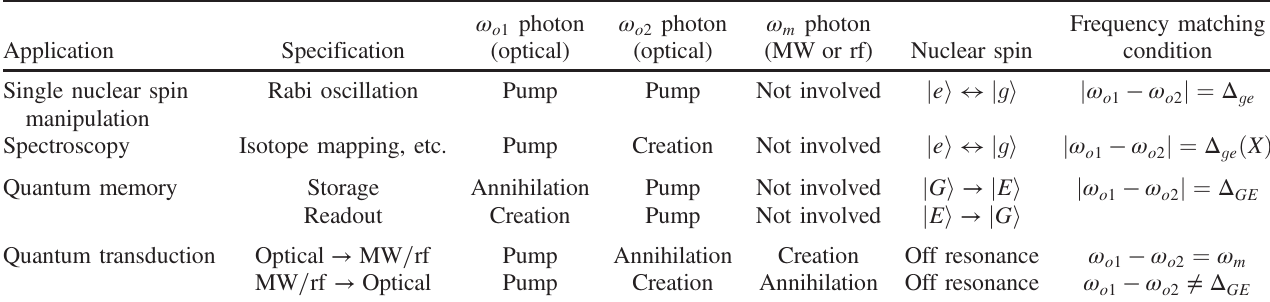
TABLE II. List of potential applications of the ONQ